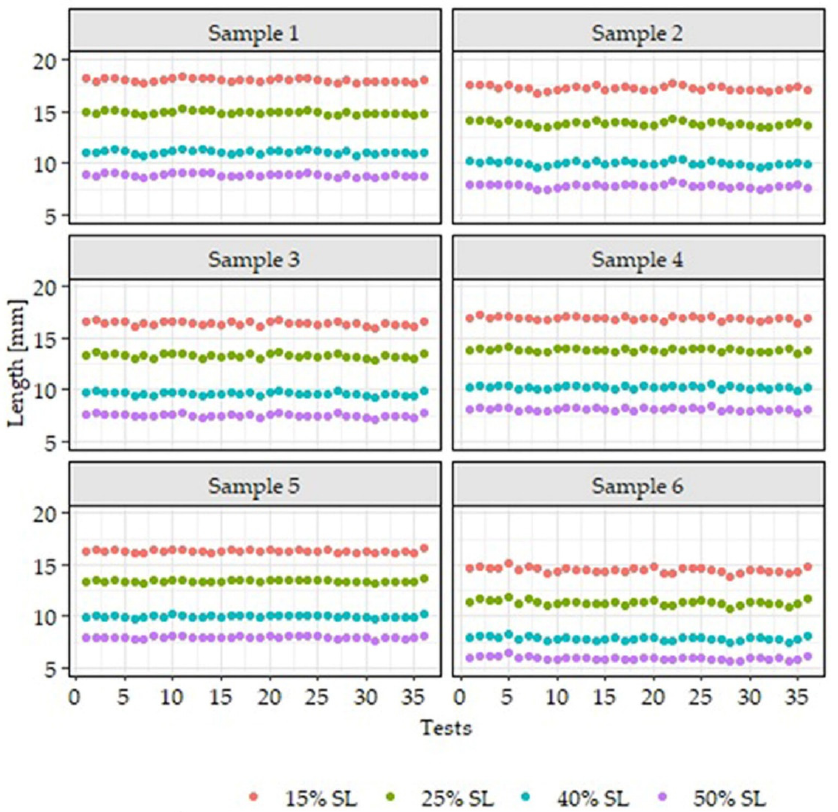
Figure 3. Scatter plots for the fibrogram measurements were taken over two weeks (short-term study). Individual data points represent the average of 10 replications. The span lengths shown are all extracted from the fibrogram.